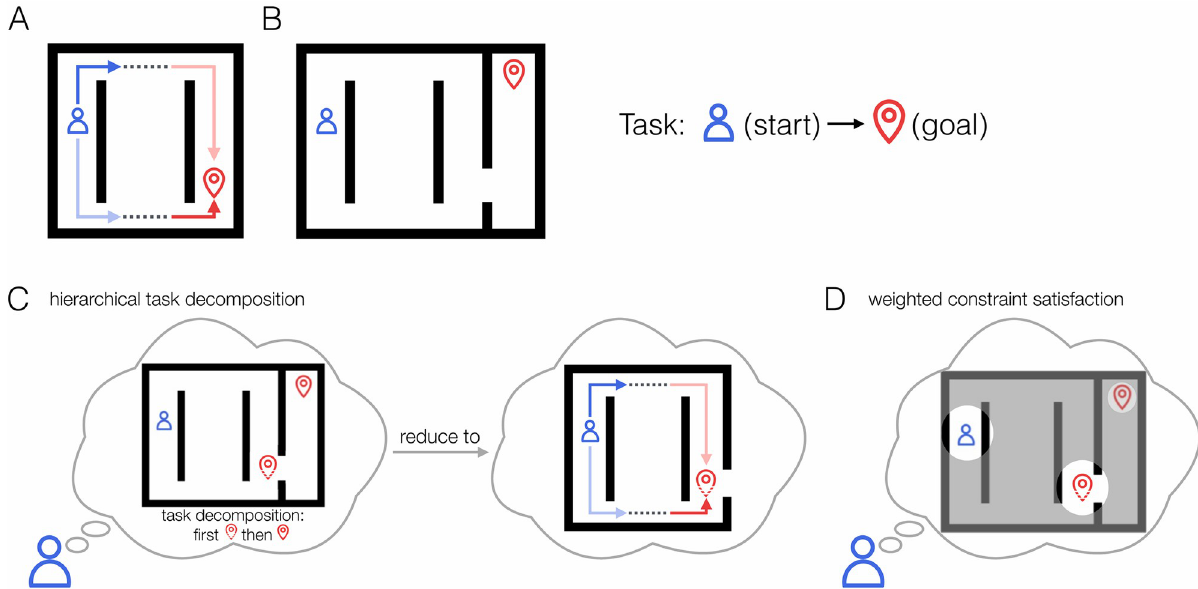
Fig 1. Hierarchical and parallel planning processes. A . A simple maze where selecting the initial direction of a best goal-reaching path benefits from the joint consideration of starting-point proximal (myopic) and goal-proximal (future) information. B . The task in A. embedded as an initial part of a larger maze. C . A hierarchical approach to selecting the initial path in B., by first reducing the task to the initial subgoal task then focusing on finding the best subgoal-reaching path. D . A parallel approach to selecting the initial path in B., where simultaneous but appropriately-weighted consideration of constraints both inside and outside of the subtask context generates approximately optimal choice